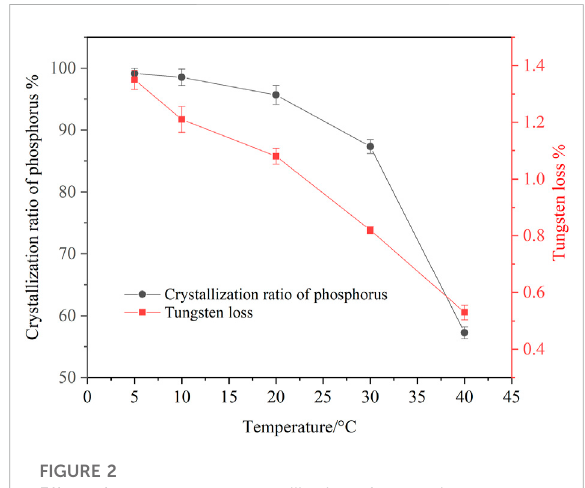
FIGURE 1 Effect of ammonia concentration on crystallization of ammonium phosphate (P 24.58 g/L, temperature 20 ° C, holding time 60 min, agitation speed 250 rpm).